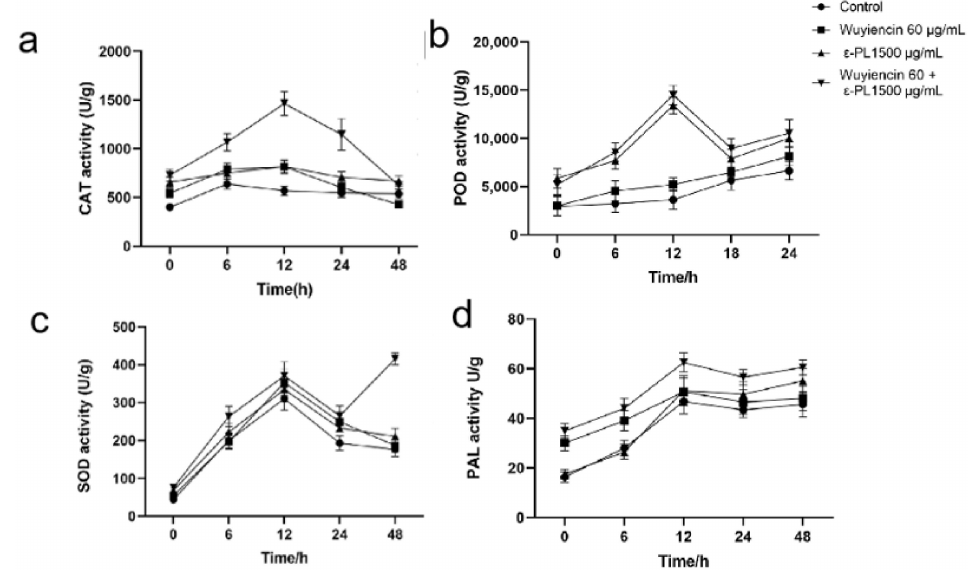
Figure 7. The effect of wuyiencin and ε -PL on defense-related enzyme activities in tomatoes. A total of 60 mg/L wuyiencin, 1500 µ g/mL ε -PL, 60 mg/L wuyiencin + 1500 µ g/mL ε -PL, and sterile water (control) were applied 3 days before the inoculation of B. cinerea spores (10 7 cfu/mL). The treated tomato leaves were incubated at 25 ◦ C with 95% relative humidity for 0, 6, 12, 24, and 48 h. Extracts were made at each time point for enzyme activity testing. ( a ): Catalase (CAT) activity changes in tomato leaves receiving the different treatments. ( b ): Peroxidase (POD) activity changes in tomato leaves receiving the different treatments. ( c ): Superoxide dismutase (SOD) activity changes in tomato leaves receiving the different treatments. ( d ): Phenylalanine ammonia-lyase (PAL) activity changes in tomato leaves receiving the different